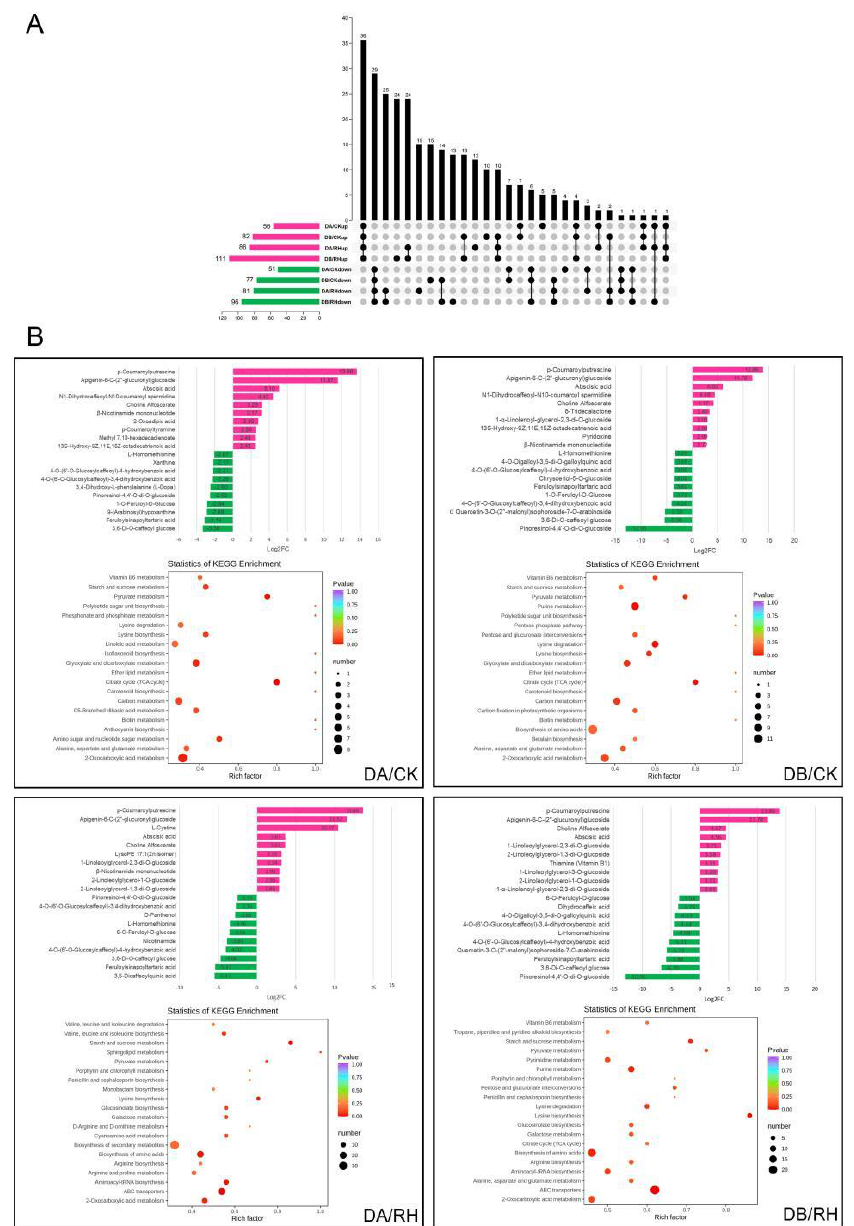
Figure 6. Comparison of upregulated and downregulated metabolites between normal conditions (CK and RH) and drought treatments (DA and DB). ( A ) Venn diagrams of significantly upregulated (red bars) and significantly downregulated (green bars) metabolites in ‘Qiuhong’ plants exposed to different periods of drought treatments. ( B ) Upper profiles are bubble plots of the KEGG enrichment pathways of DAMs between normal conditions and drought treatments. Lower profiles are the top 10 up- and downregulated DAMs. Red bars indicate upregulated DAMs. Green bars indicate downregulated DAMs. Data were plotted using TBtools (Toolbox for biologists) V0.67.